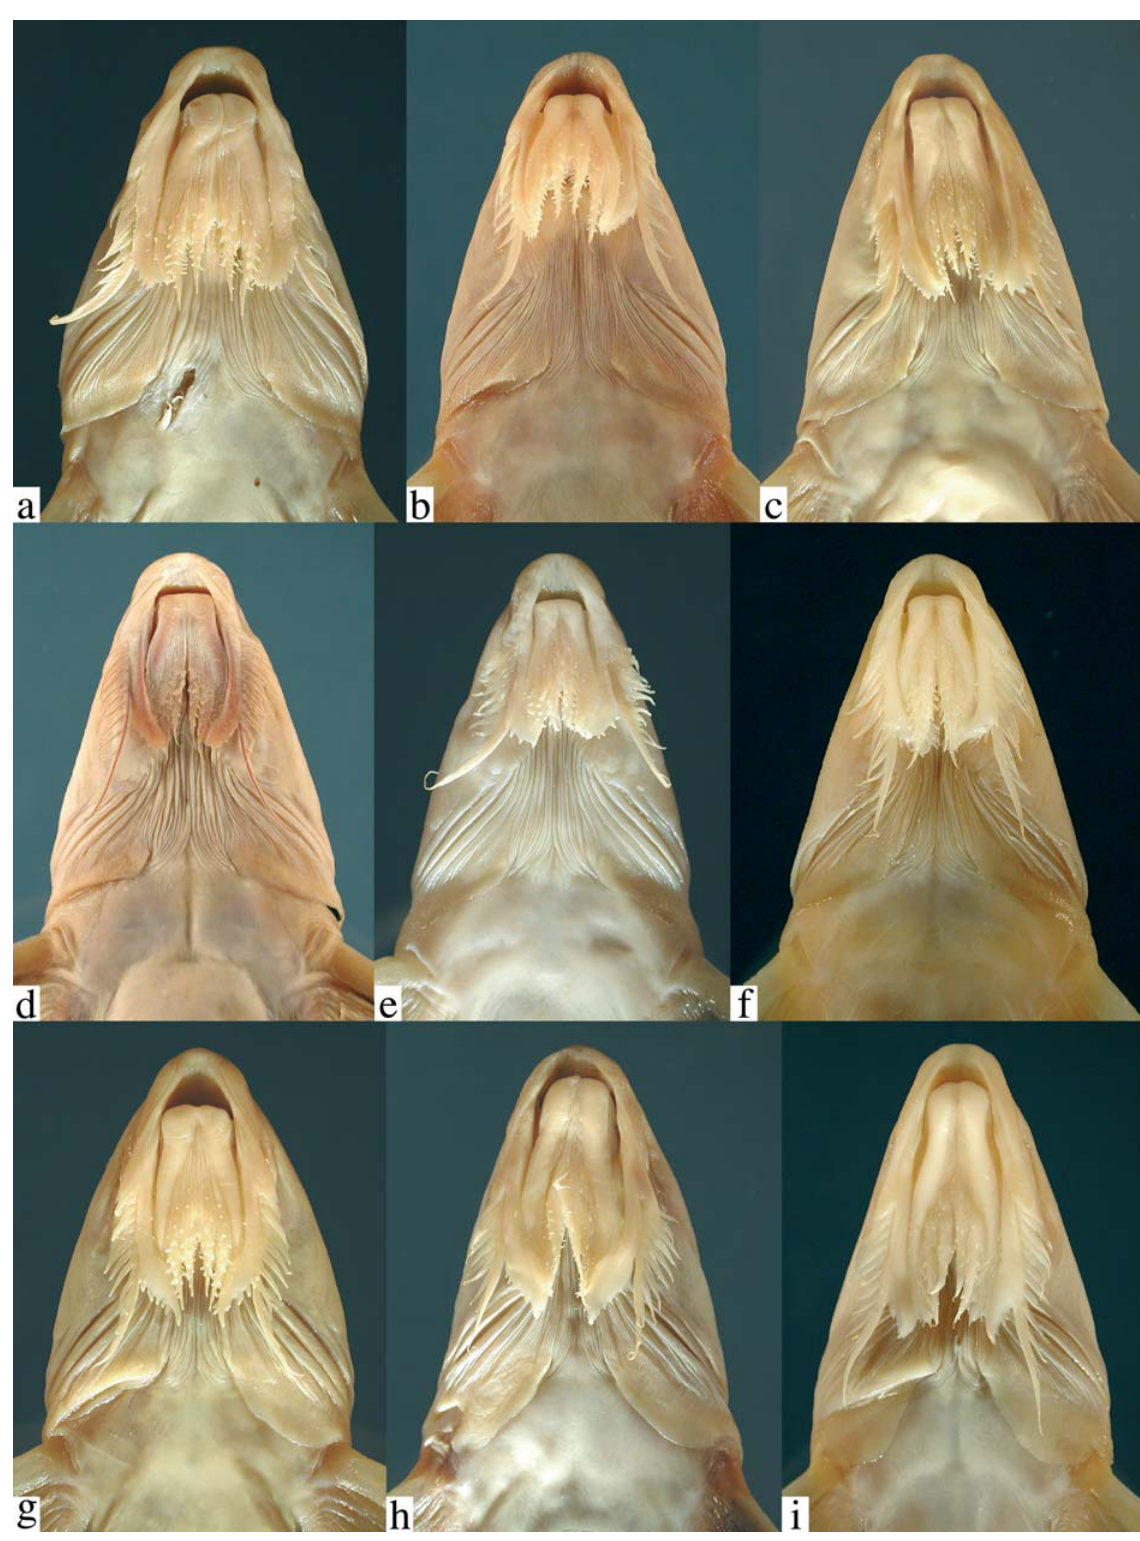
Fig. 5. Ventral views of heads in Leptodoras . a. L. linnelli , MBUCV-V 16602 (SL 157 mm). b. L. nelsoni , MBUCV-V 14769 (SL 135.8 mm). c. L. rogersae , USNM 226307 (SL 180 mm). d. L. acipenserinus , FMNH 92385 (SL 155 mm). e. L. acipenserinus , FMNH 97140 (SL 113.3 mm). f. L. acipenserinus , ANSP 178467 (SL 107.9 mm). g. L. cataniai , ANSP 161532 (SL 142.6 mm). h. L. cf. cataniai Amazon form, ANSP 180925 (SL 194 mm). i. L. cf. cataniai Nanay form, ANSP 178438 (SL 164.2